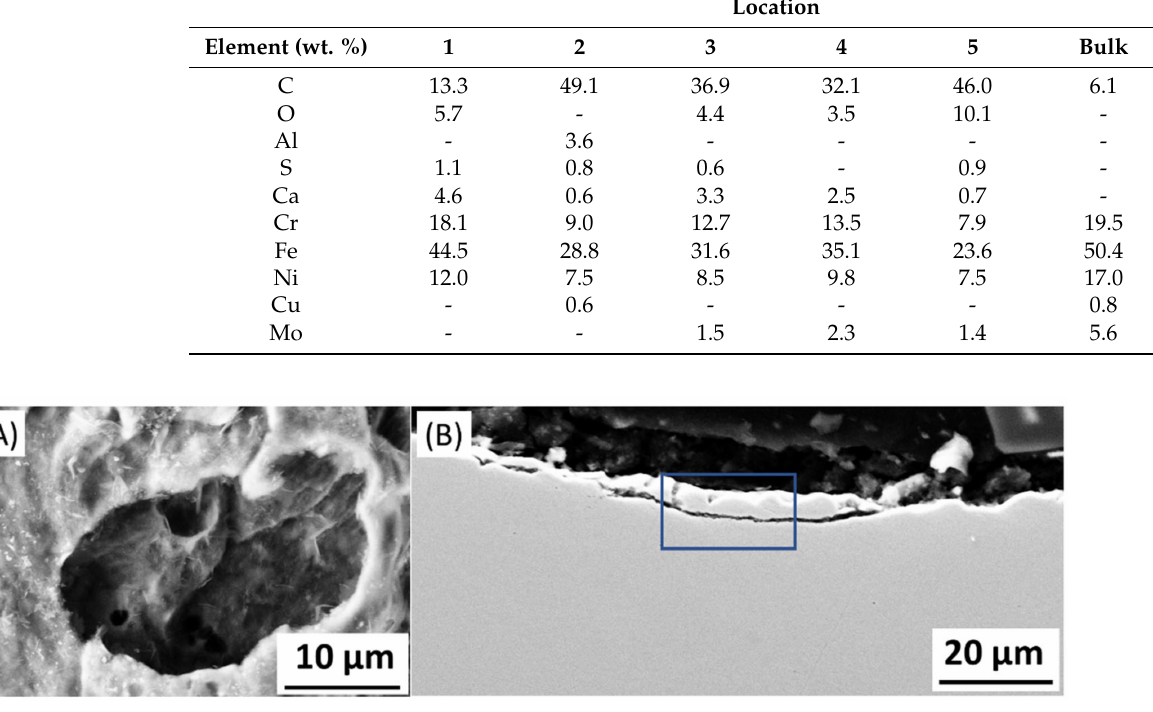
Figure 15. 254SMO microstructural analysis using secondary detector (SEM) from Reykjanes exposed sample ( A ): Pit found at the surfaces of the 254SMO. ( B ): Cross-section where a sub-crack is present. The area marked in blue is further analysed in Figure 16.